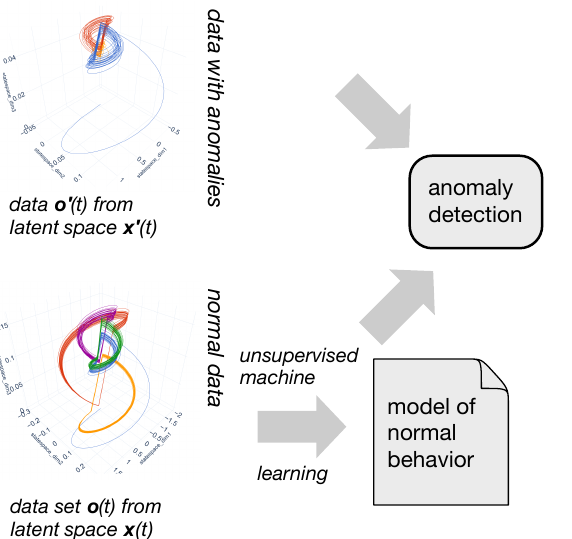
Figure 3. Using anomaly detection for the evaluation of unsupervised machine learning